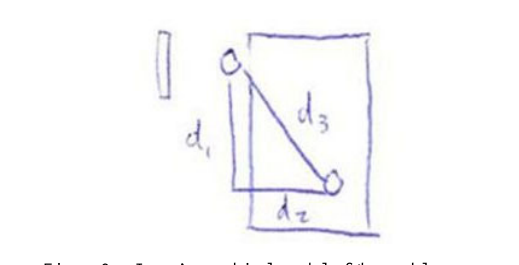
Figure 9. Jason’s graphical model-of the problem.